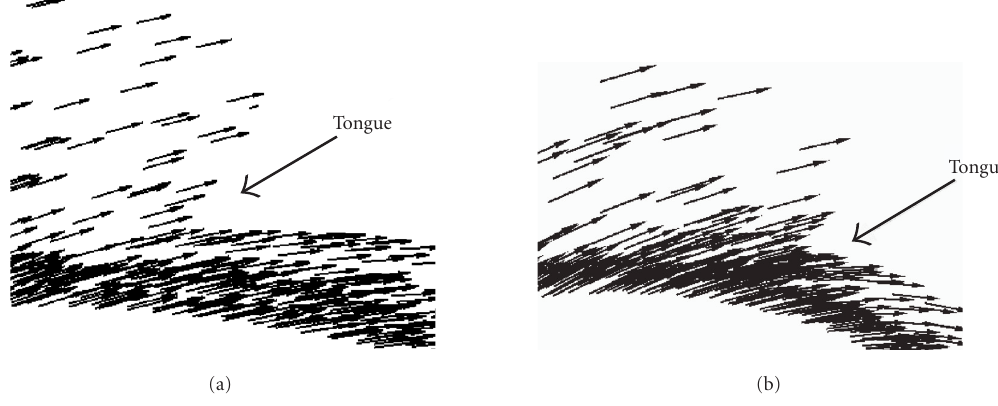
Figure 8: The velocity vectors near the intersection between the midplanes of the di ff user and tongue, showing the basic flow structure. (a) Sharp tongue. (b) Round